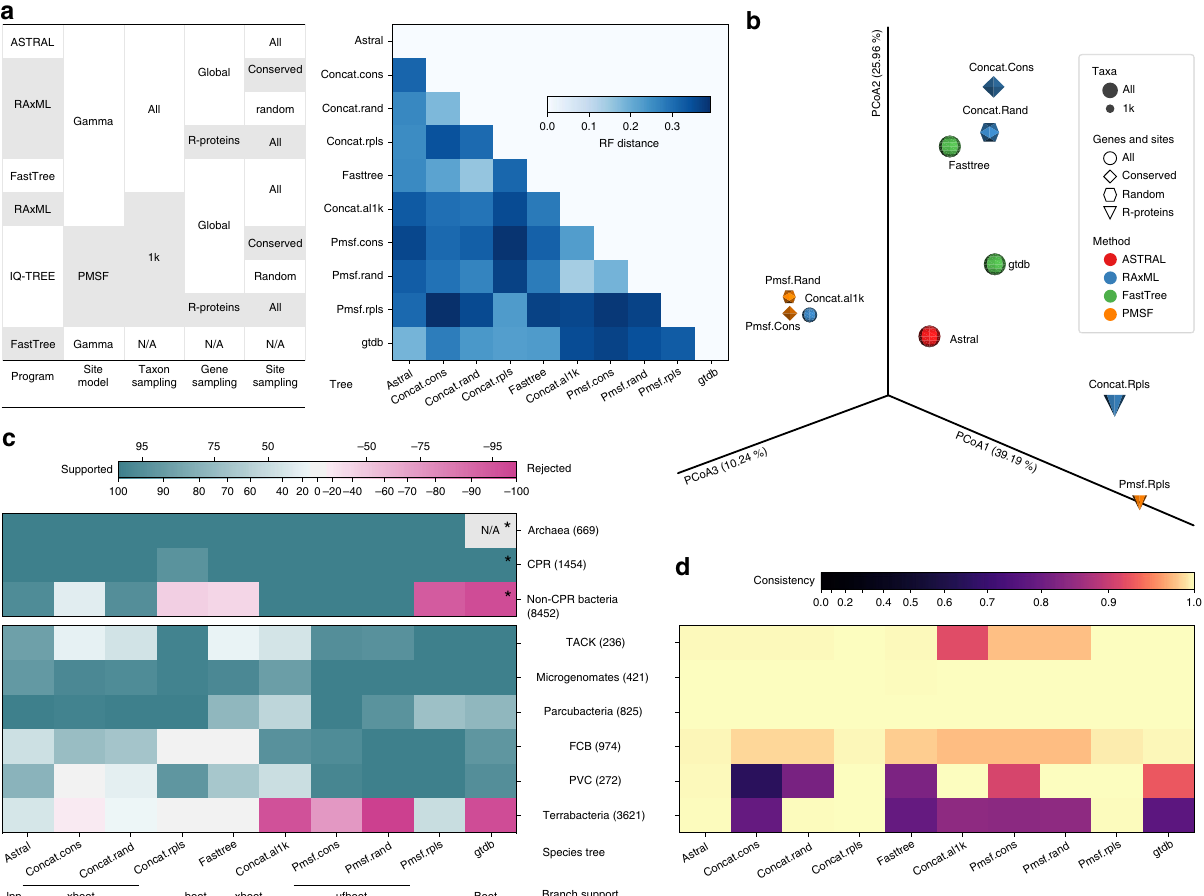
Fig. 3 Comparison of topologies of multiple species trees. Nine species trees reconstructed in this study, plus a previously published tree, GTDB release 86.1 were cross-compared. The methods for building those trees are summarized in the inset table. a Matrix of normalized Robinson – Foulds (RF) distance, which measures the overall topological discrepancy between two trees based on the shared taxa. b PCoA of the RF distance matrix. c Branch support- informed support/rejection degrees (see the Methods section) for the monophyly of Archaea, CPR, and non-CPR Bacteria, and six super phyla de fi ned by NCBI. Clades were de fi ned according to the tax2tree auto-curation result based on each tree. Note that super phyla Asgard (eight taxa) and DPANN ( fi ve taxa) are not shown due to low taxon representativeness, but are discussed in Supplementary Note 5. Numbers in parentheses indicate the number of taxa under each clade according to the ASTRAL tree. The types of branch support values are indicated below tree names: “ lpp ” : local posterior probability, “ boot ” : classical bootstrap, “ xboot ” : rapid bootstrap, “ ufboot ” : ultrafast bootstrap. Note that different branch support types cannot be directly compared. Note (*) that the GTDB phylogeny consists of two trees independently built for Archaea and Bacteria, respectively, thus the support/rejection for Archaea cannot be assessed. Meanwhile, the bacterial tree was rooted using a midpoint strategy, making Chloro fl exi the outgroup to all remaining bacteria (including CPR). But it should not be considered as a rejection to the monophyly of non-CPR Bacteria in the sense of evolutionary relationships. d Consistency between NCBI-de fi ned super phyla and tree topologies, computed using tax2tree (see Methods). Source data are provided as a Source Data fi